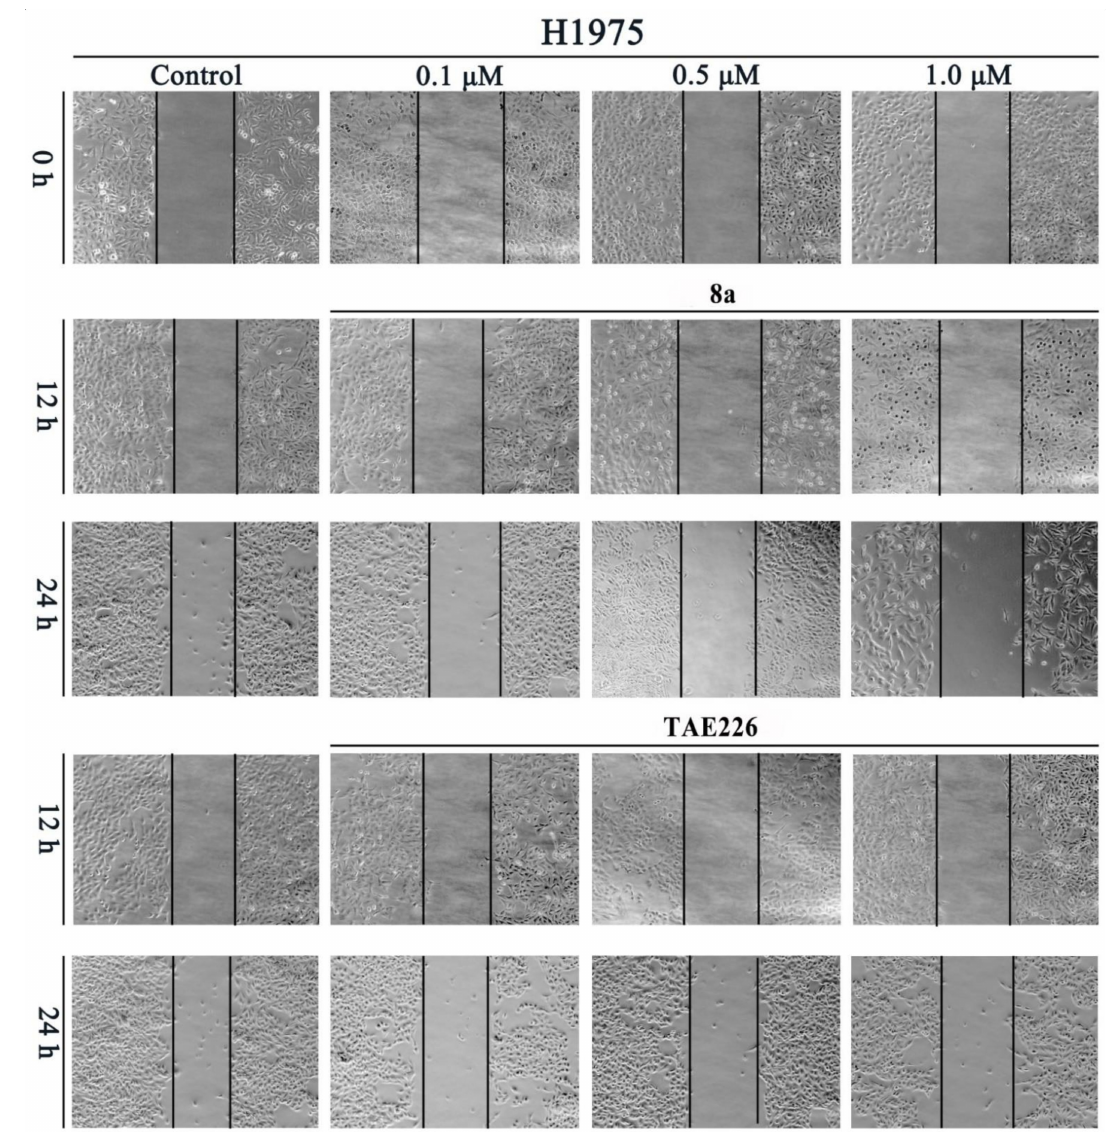
Figure 9. Effects of compound 8a and TAE226 on the migration of H1975 cells in vitro determined by the scratch assay. H1975 cells were incubated with different concentrations of compound 8a and TAE226 (0.1, 0.5, and 1 µ M) for 24